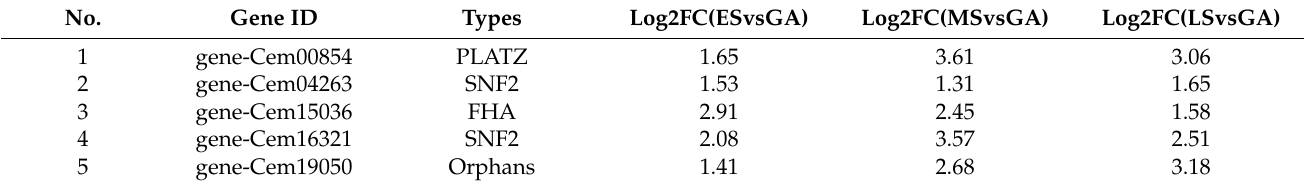
Table 1. Transcriptional factors of G. emersonii that were continuously upregulated because of infection.